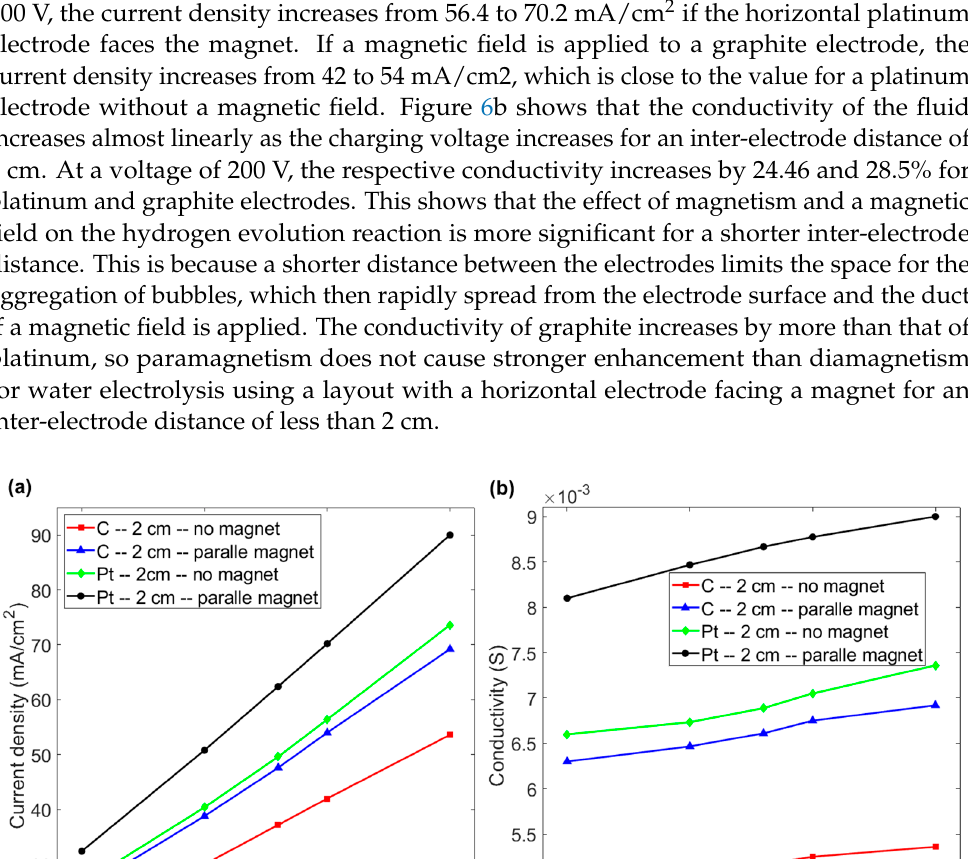
Figure 7. ( a ) Current density vs. inter-electrode distance for graphite and platinum electrodes with and without a magnet for various inter-electrode distances. ( b ) Conductivity vs. inter-electrode dis- tance for the various experimental layouts in Figure 7a: the charging voltage is 200 V.